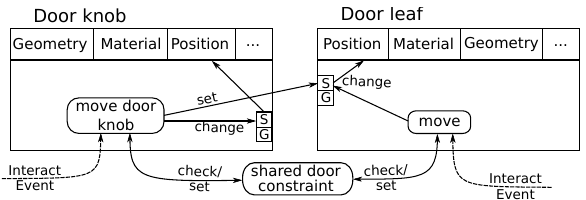
Objects and functionalities needed to represent a door. The S/G boxes symbolize the mediators to call set/get-methods in order to access the attributes shown in the top of the objects.